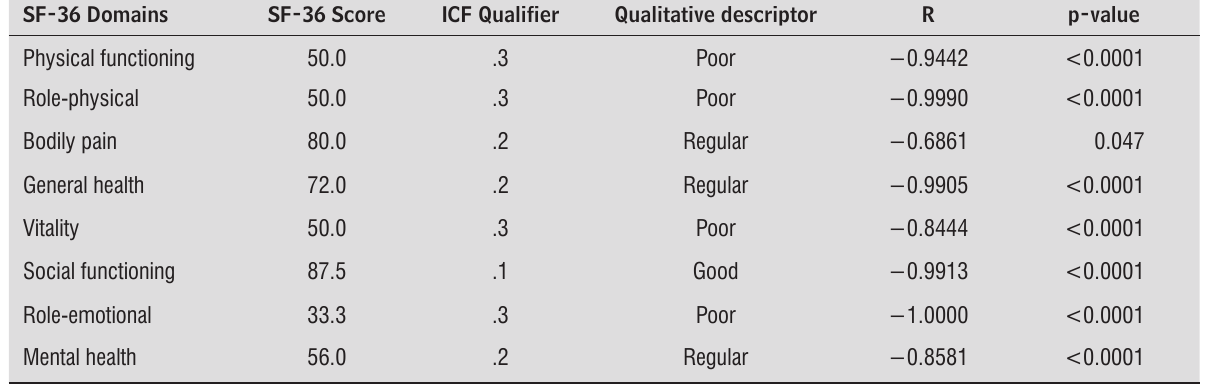
Table 4 - Median values assigned to SF-36 domains and ICF qualifiers, and the correlation between these